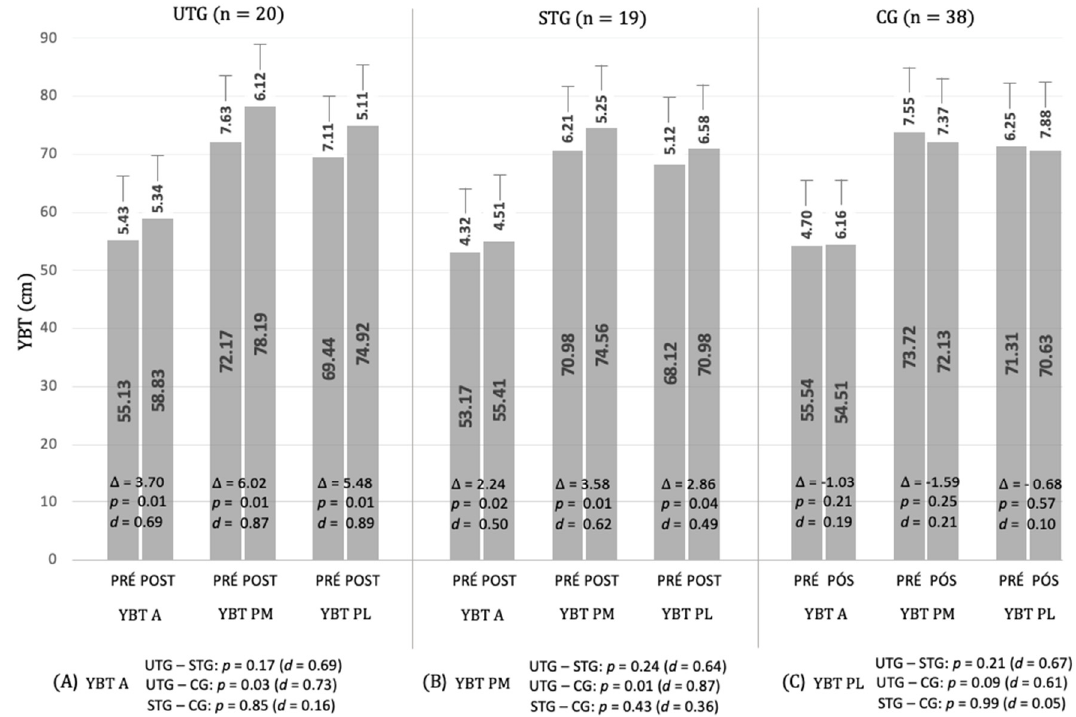
Figure 2. Mean (±SD) of Y Balance Test measures after the 9-week intervention. YBT—Y Balance Test; A—anterior reach direction; PM—posteromedial reach direction; PL—posterolateral reach direction; UTG—unstable training group; STG—stable training group; CG—control group; ( ∆ ) change from baseline to post-intervention; p (values) for the difference in pre- and post-measures; d = effect size: 0.0–0.2, trivial; 0.2–0.6, small; 0.6–1.2, moderate; 1.2–2.0, large; >2.0 very large. (A) Significant differences between groups for YBT A; (B) significant differences between groups for YBT PM; (C) significant differences between groups for YBT PL.